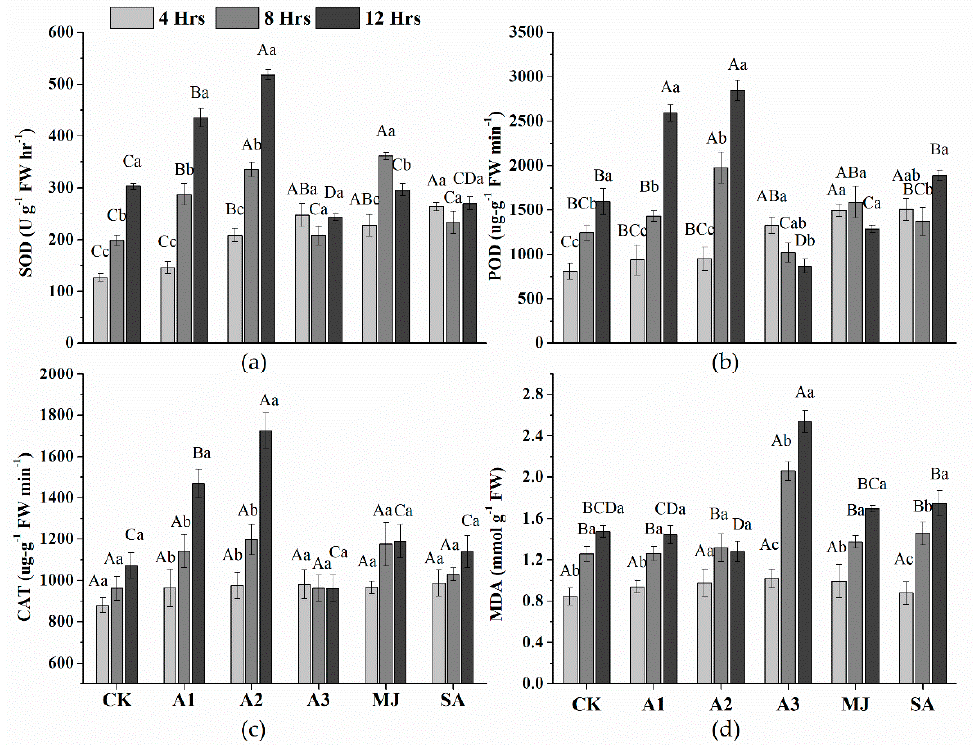
Figure 4. Priming e ff ect of AGE, MeJA, and SA on the antioxidant enzymes and MDA content of eggplant seedlings. ( a ) Superoxide dismutase (SOD), ( b ) peroxidase (POD), ( c ) catalase (CAT) and ( d ) malondialdehyde (MDA). Ck (distilled water), A1, A2, A3 (AGE 100, 200, 300 µ g mL − 1 ), MJ (MeJA 0.05 mM), SA (Salicylic acid 0.5 mM), whereas 4, 8-, and 12-h are priming durations. Bars represent mean and standard errors ( n = 4). Data were subjected to analysis of variance ANOVA. Same letters on the bars bear no significant di ff erence at p = 0.05 (LSD), whereas, capital letters represent significant di ff erence among chemical treatments and small letters represent significant di ff erence among the priming durations.